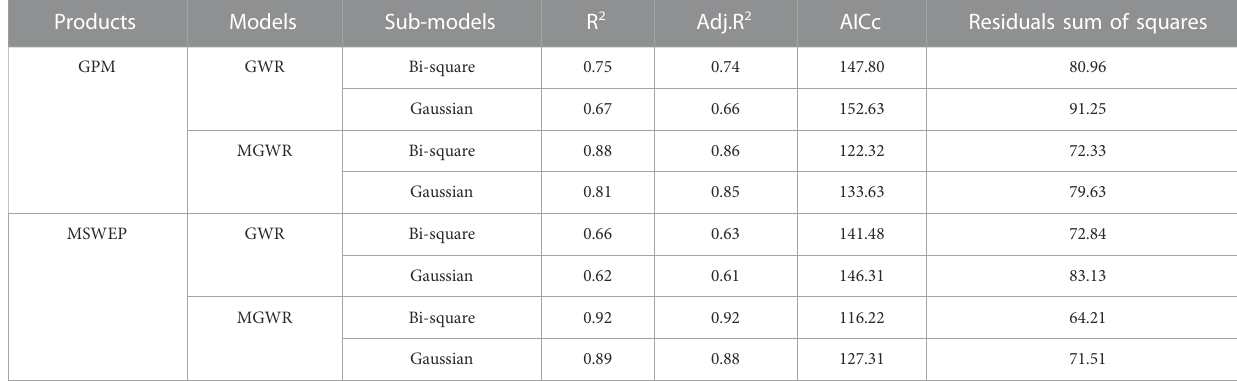
TABLE 2 Compares the performance of GWR and MGWR models using two different weight functions (GU and BI). Products